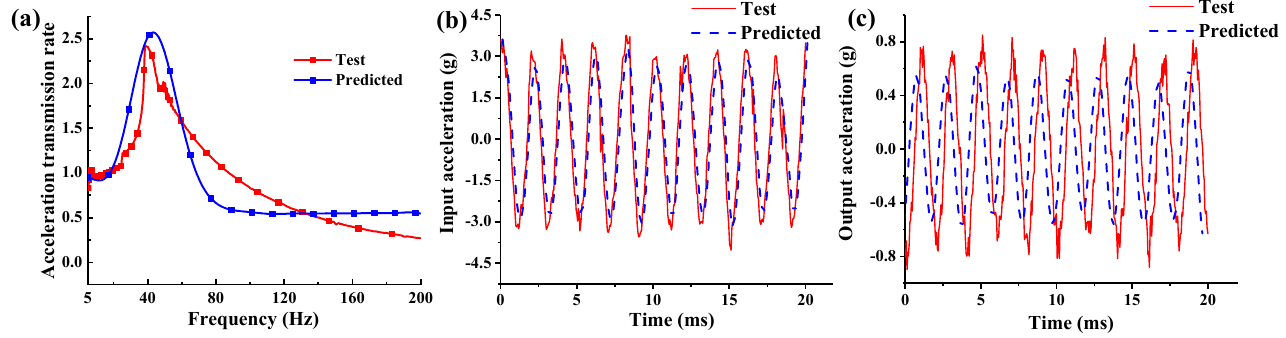
Figure 10. Comparison between the experimental and predicted curves: ( a ) acceleration transmission rate, ( b ) input acceleration, and ( c ) output acceleration.